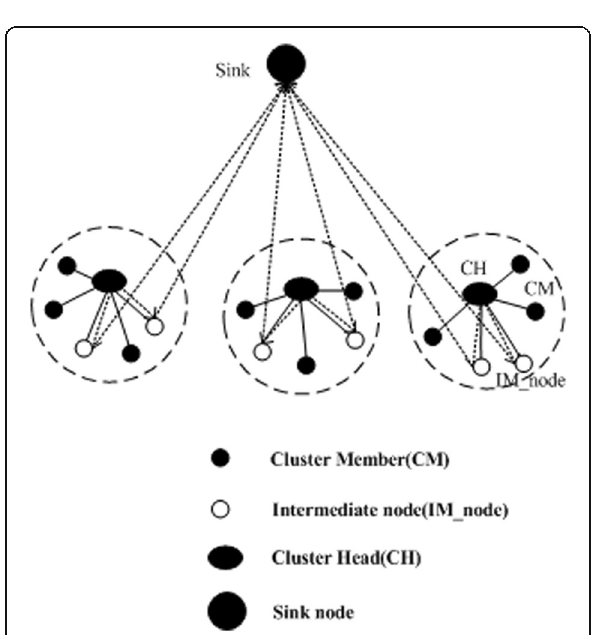
Fig. 4 AMAPTEEN network model. The AMAPTEEN network model consists of CM, CH, IM_node, and sink node four parts. CM sends the sensed data to CH, and CH collects and fuses data and sends the fusion of data to IM_node. IM_node forwards the data to a distant sink